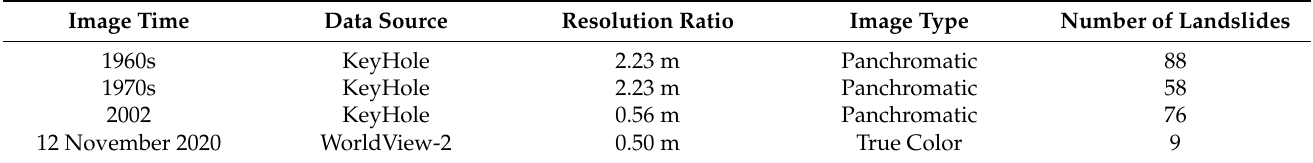
Table 2. Multitemporal ORS dataset information and interpretation